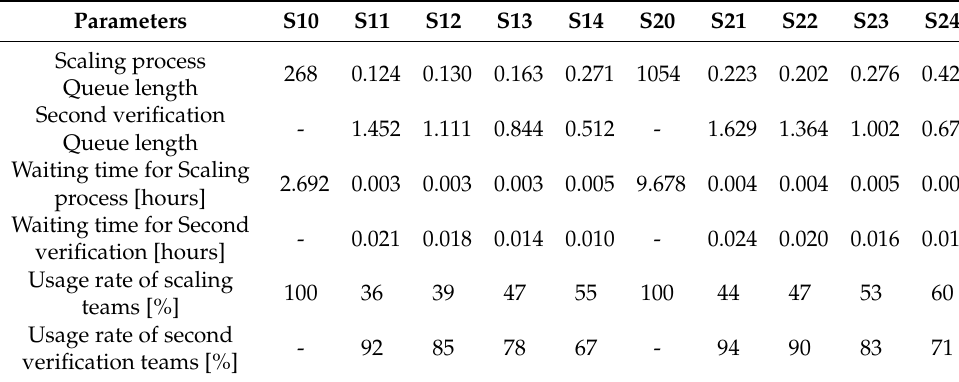
Table 3. The simulation